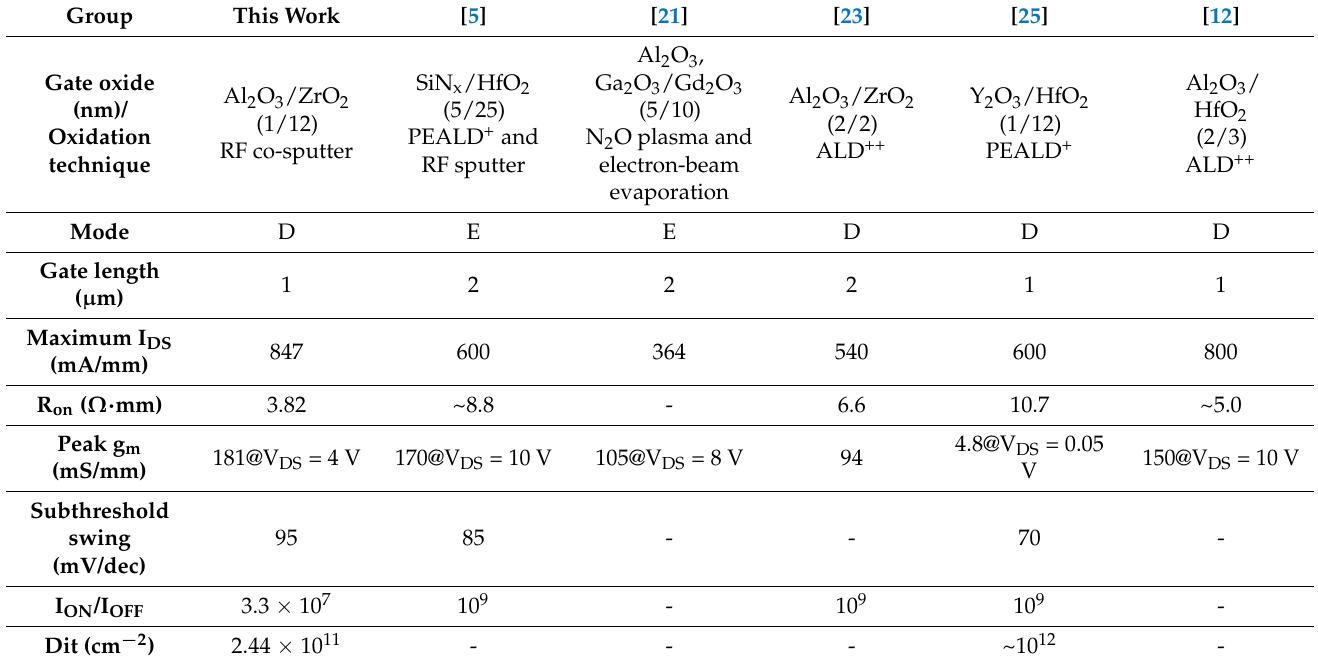
Table 1. A summary of the dc characteristics of MOS-HEMTs with different stacked gate dielectrics in this work and by other